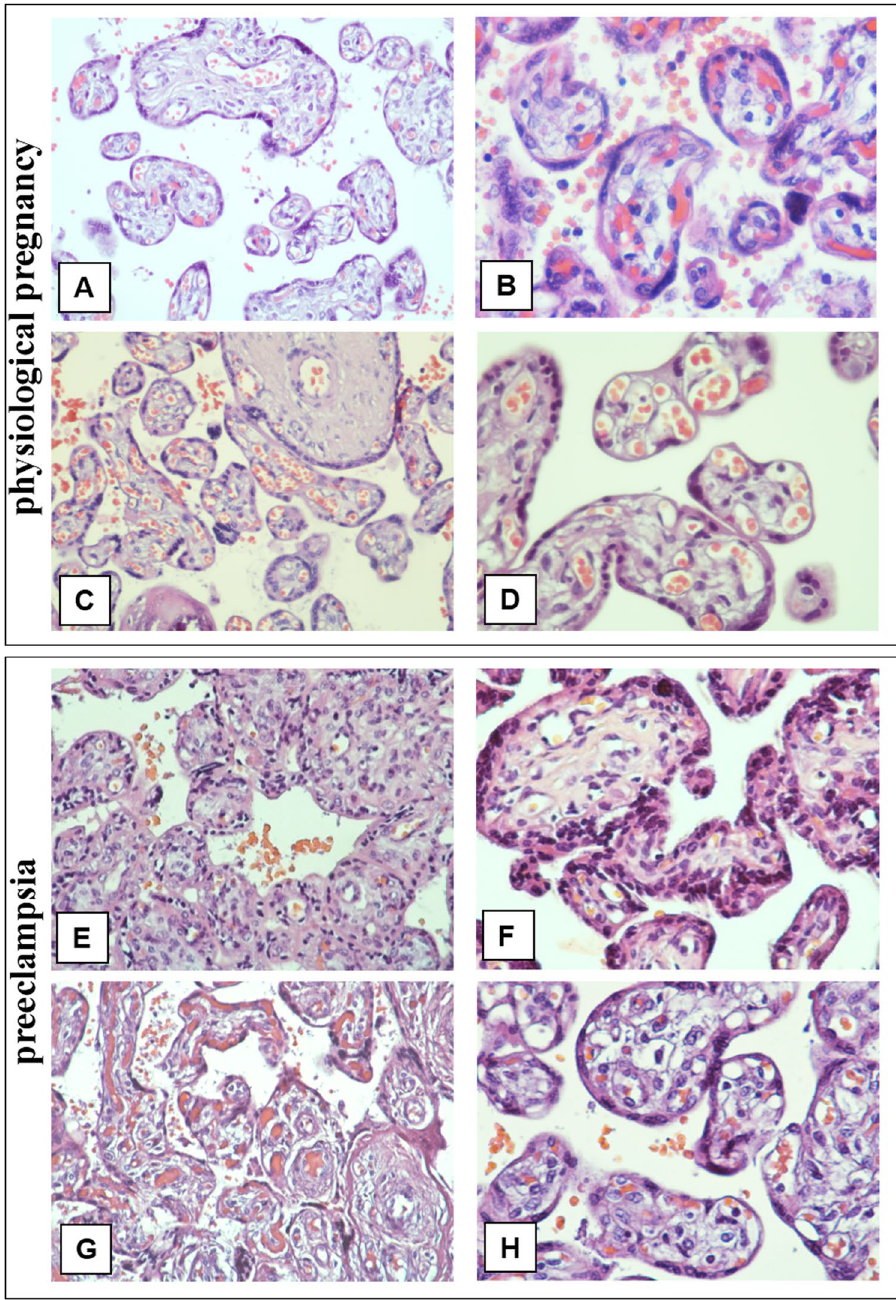
Figure 1. Histological examination of placental villous trees in preeclampsia and physiological pregnancies (staining with haematoxylin and eosin). ( A–D ) Morphological changes in placental villous trees during physiological pregnancy. ( А and B ) Placenta at the 27 th week (intermediate villi dominate). ( A ) х200. ( B ) x400. ( C and D ) Placenta at the 38 th week (stem, intermediate and terminal villi were found). ( C ) х200. ( D ) х400. ( E and F ) Morphological changes in the villous trees in early-onset PE (at the 26 th week) (stromal fibrosis and fibrinoids are detected). ( E ) х200. ( F ) x400. ( G ) The stem villi depicted show a high degree of apoptosis in structural constituents. Hofbauer cells located inside the stromal channels are marked to differentiate them from other cell types. ( G ) х200. ( H ) Morphological changes in late-onset PE (at the 38 th week) (stem villi are not completely formed and stromal channels with circulating macrophages (Hofbauer cells) are present in the villi). ( H )